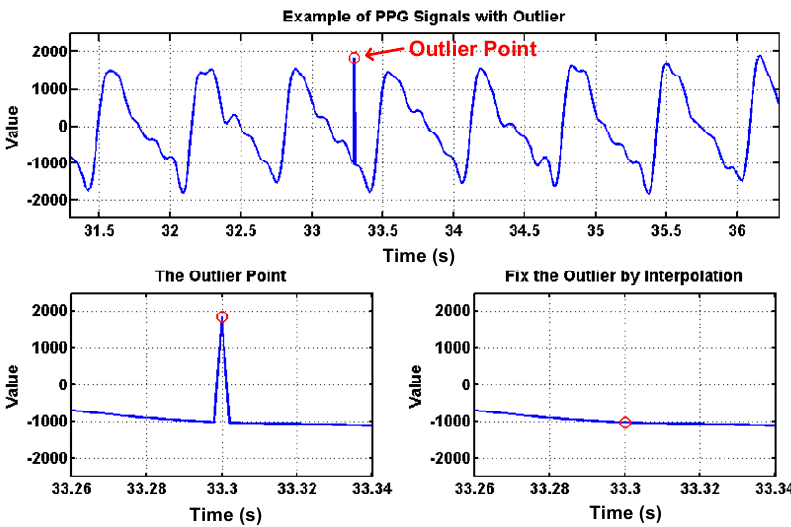
Figure 8. PPG signals with an outlier point, which can be detected by slope and can be fixed by using interpolation.